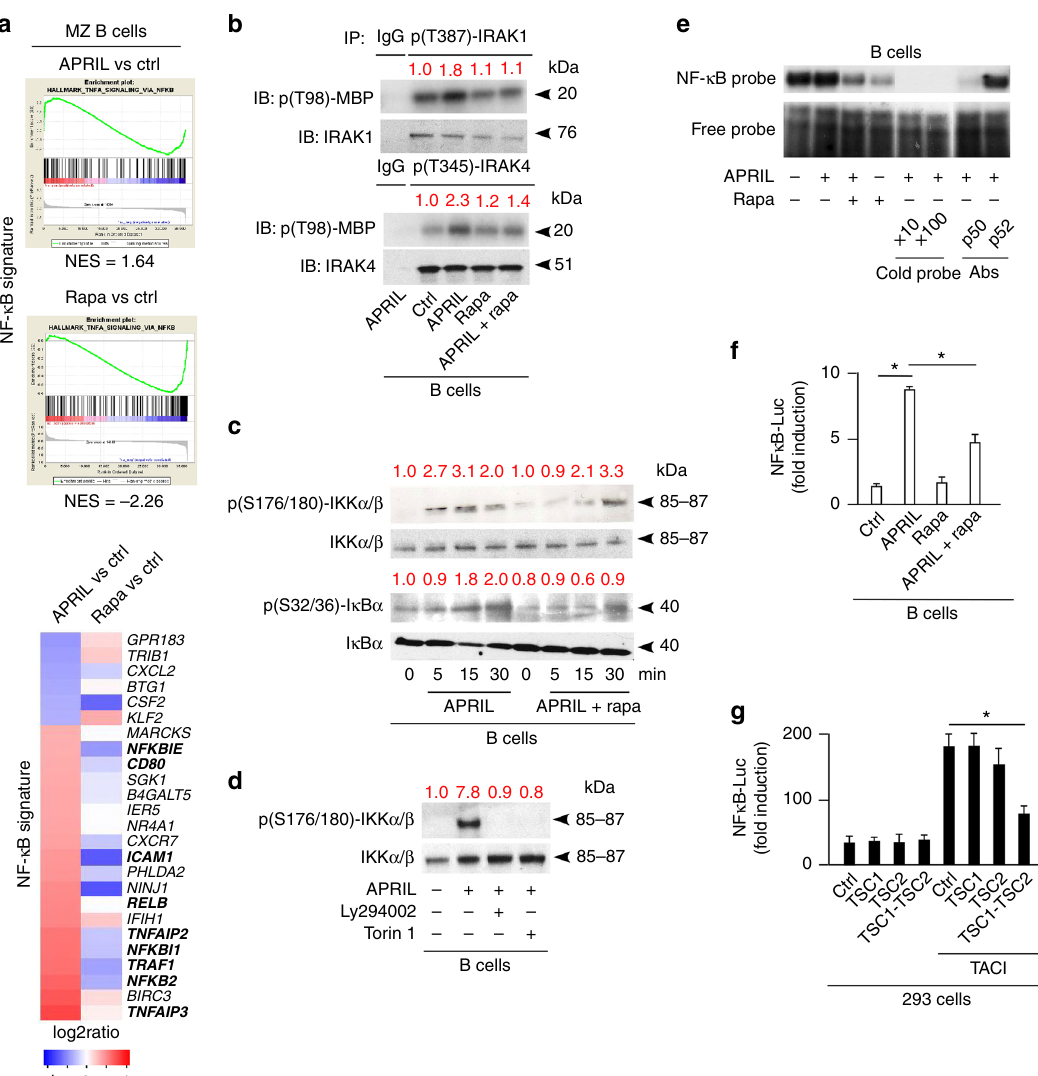
Fig. 4 TACI activates the CSR-inducing transcription factor NF- κ B through mTORC1. a GSEA showing enrichment or depletion of coordinated NF- κ B gene sets from human splenic MZ B cells cultured for 3 h with or without APRIL or rapamycin (rapa). Ctrl, medium alone. NES indicates correlation between individual gene sets. Positive correlation, NES > 0; negative correlation, NES < 0. Heat map shows top 25 genes similarly enriched or depleted in MZ B cells exposed to different treatments. Colors correspond to signi fi cant FC expression: red (high); blue (low). Bold indicates genes discussed in the text. b IB of p (T98)-myelin basic protein (MBP), IRAK-1 and IRAK-4 following IP with anti-p(T387)-IRAK-1, p(T354)-IRAK-4, or irrelevant IgG of protein lysates from human 2E2 B cells cultured for 15 min with or without APRIL and/or rapamycin (rapa). Red numbers indicate band intensity relative to total proteins. c IB of total or p(S176/180)-IKK α / β and total or p(S32/36)-I κ B α from human splenic IgD + B cells incubated with APRIL in the presence or absence of rapamycin for 0, 5, 15, or 30 min. d IB of total or p(S176/180)-IKK α / β from human splenic IgD + B cells incubated with or without APRIL in the presence or absence of Ly294002 or Torin 1 for 15 min. e EMSA of nuclear NF- κ B bound to a radiolabeled κ B DNA probe from human splenic IgD + B cells incubated with APRIL in the presence or absence of rapamycin for 1 h (lanes 1 – 4). NF- κ B – DNA interaction in the presence of increasing concentrations of a competing unlabeled cold probe (lanes 5 – 6) or blocking antibodies (Abs) to p50 and p52 NF- κ B subunits (lanes 7 – 8) are also shown. f NF- κ B-Luciferase (Luc) reporter assay of human EBV-transformed B cells incubated with APRIL in the presence or absence of rapamycin for 24 h. g NF- κ B-Luc reporter assay of 293 cells expressing WT TACI with or without TSC1, TSC2, or both for 24 h. Ctrl, empty plasmid. Data summarize one representative experiment with at least three samples or biological replicates from each cell type ( a , f , g ), show one of at least three ( b , d ) or two ( e ) experiments with similar results. Error bars, s.e.m.; * p < 0.05 (two-tailed Student ’ s t downstream constant µ (C µ ), C γ , C α or C ε gene 39 . Besides inducing the CSR-inducing enzyme activation-induced cytidine deaminase (AID), NF- κ B-activating receptors such as TACI stimulate I H promoters to initiate germline I H -S-C H transcription and AID-mediated CSR 39 . This process removes the DNA between targeted S regions to generate extrachromosomal switch circles encoding I µ -C X transcripts, a hallmark of ongoing CSR 39 .